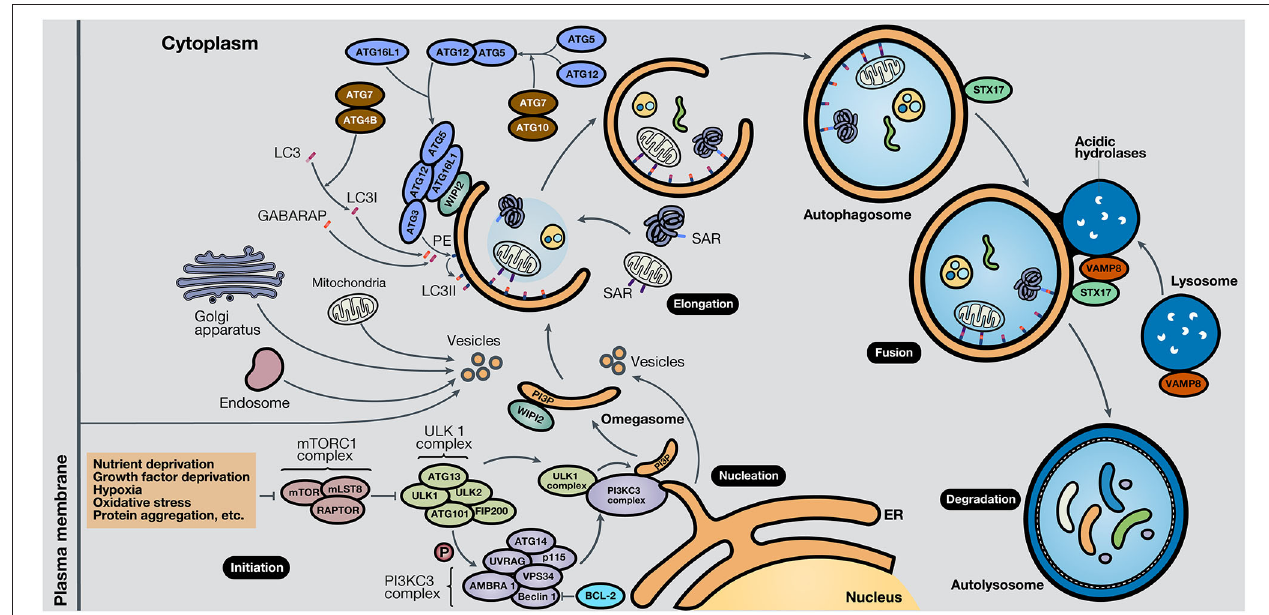
FIGURE 2 | Schematic representation of the autophagy process. The autophagy mechanism consists of five phases. In the initiation phase, mTORC1 is inactivated due to autophagy-stimulating signals, liberating the repression of the ULK1 complex. During the nucleation phase, the ULK1 complex phosphorylates the PI3KC3 complex, which induces phagophore formation in the omegasome, through the production of PI3P and association with WIPI protein family members, commonly WIPI2. In the elongation phase, two ubiquitin-like protein systems, ATG12-ATG5-ATG16L1 and ATG4B-ATG7-ATG3, mediate the activation of LC3 into LC3I, lipidation with PE to form LC3II, and subsequent anchoring to the phagophore. GABARAP also conjugates with PE and attaches to the membrane. LC3 and GABARAP mediate the sequestration of autophagic substrates marked with SARs, such as p62/SQSTM1, before phagophore closure and total autophagosome development. During the fusion phase, STX17 and VAMP8, present in the autophagosome and lysosome, respectively, interact and stimulate autolysosome formation. Finally, in the degradation phase, acidic lysosomal hydrolases degrade autophagic cargo, generating nutrients that are released to the cytoplasm and reused by the cell. ER, endoplasmic